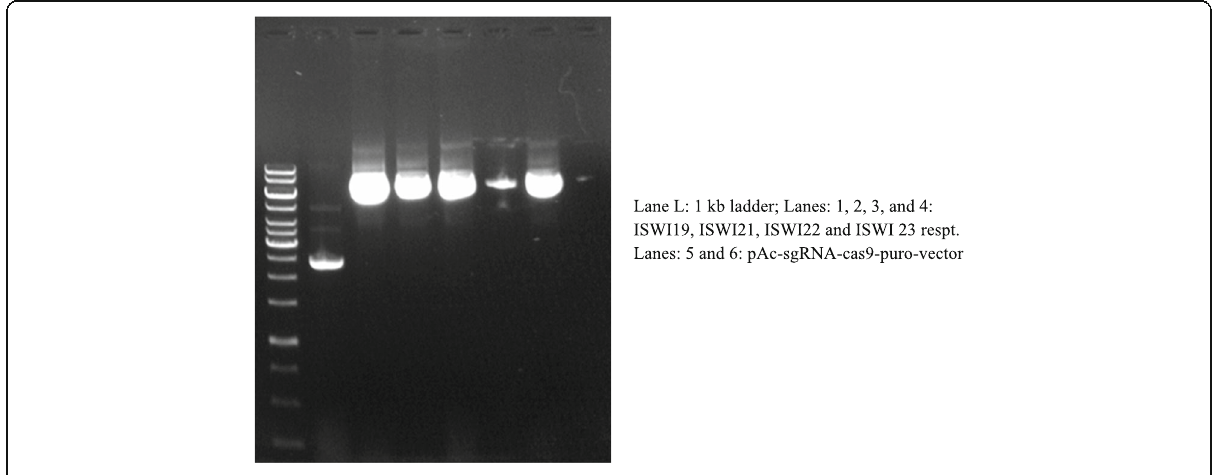
Fig. 4 1% agarose gel of recombinant plasmids of ISWI guide